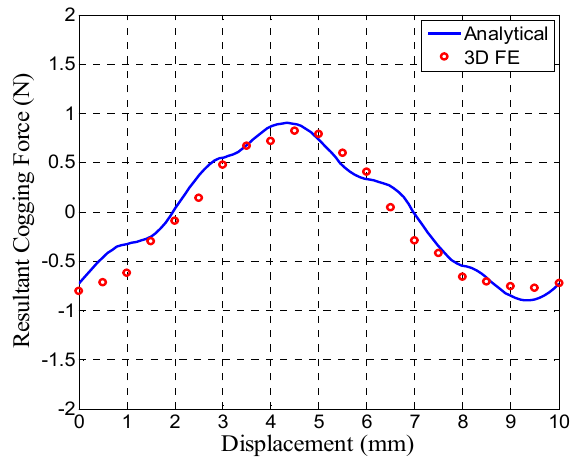
Figure 10. Cogging force waveform of the PMLM with skewed magnets.